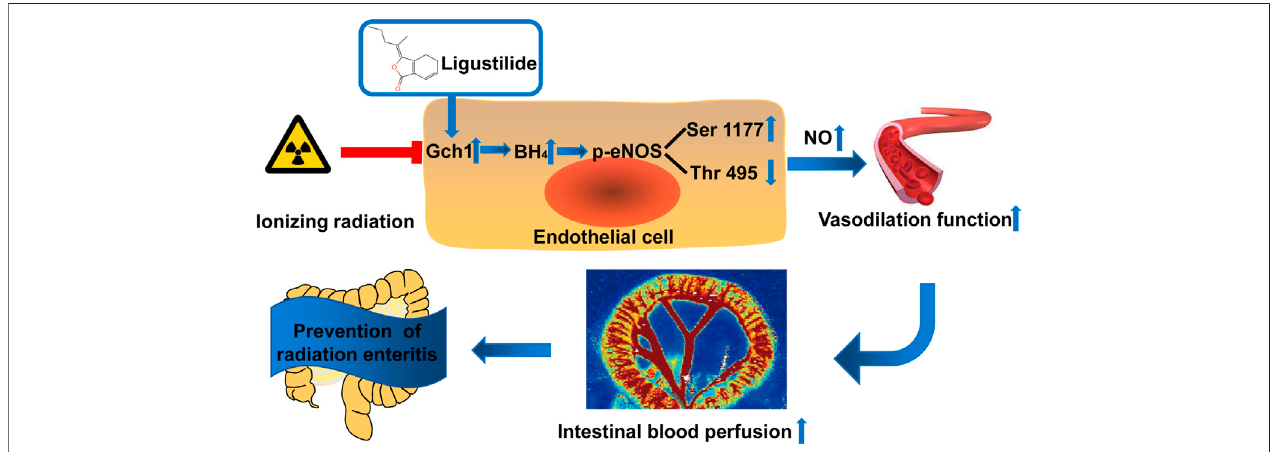
FIGURE 7 | Schematic illustration. Ligustilide prevents radiation enteritis by targeting to improve the levels of Gch1 and eNOS phosphorylated s1177 proteins in vascular endothelial cells after ionizing radiation, increase the production of BH 4 and NO, correct vascular diastolic function, and maintain intestinal blood